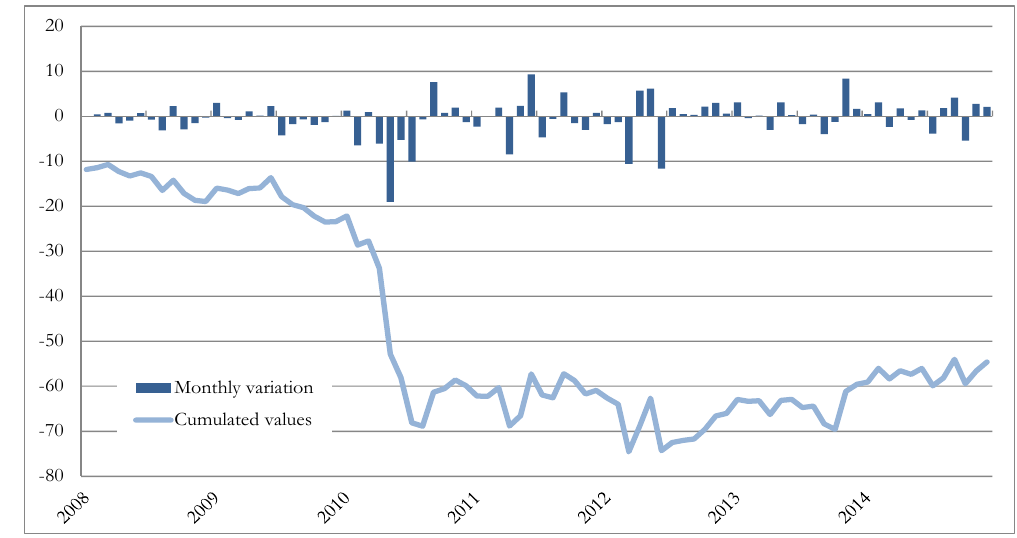
Figure 4. TARGET2 balances towards the Eurosystem, Portugal (Euro billion, monthly, end of the period). Source: Elaboration on the “Institute of Empirical Economic Research—Osnabrück University” dataset (accessed on 25 June 2015, http://www.